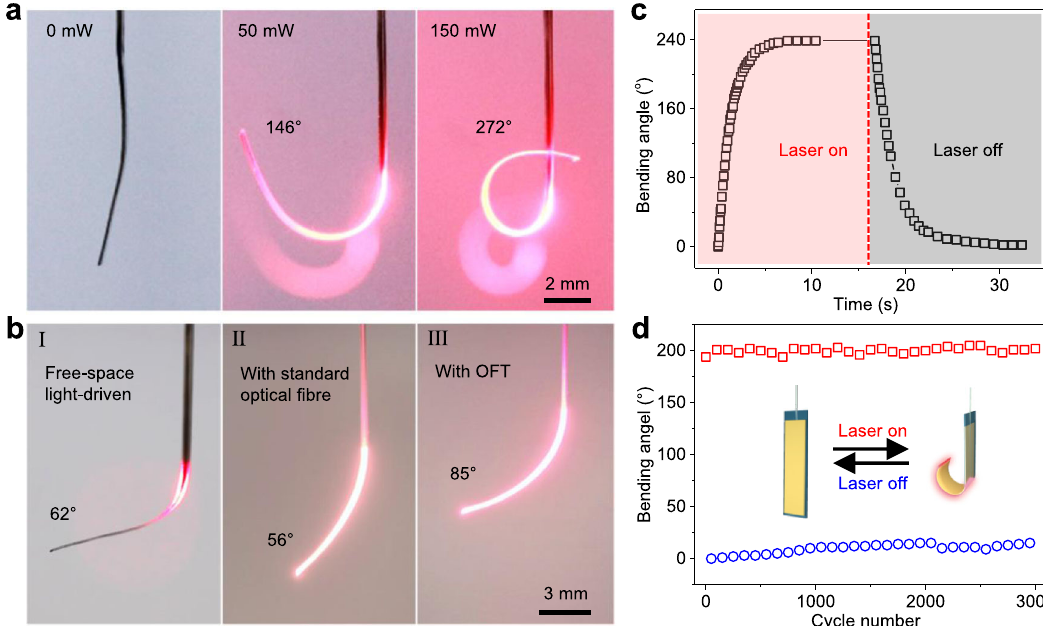
Fig. 3 Light-driven actuating performances of OPA. a Photographs showing the light-driven bending of an OPA (10 × 0.5 × 0.07 mm 3 ) under different laser powers. b Free-space light-driven bending of the OPA (I), waveguided light-driven bending of an actuator (thickness of ~220 μ m) fabricated using a standard optical fi bre (II), and waveguided light-driven bending of OPA with a thickness of ~225 μ m (III) under 635 nm-wavelength laser (150 mW). c Light-driven bending of an OPA (the same as in a ) exposed to 635 nm-wavelength laser as a function of time. Source data are provided as a Source Data fi le. d Bending angles of the OPA over 3000 cycles of on-off switch of laser with a power of 100 mW. Source data are provided as a Source Data fi